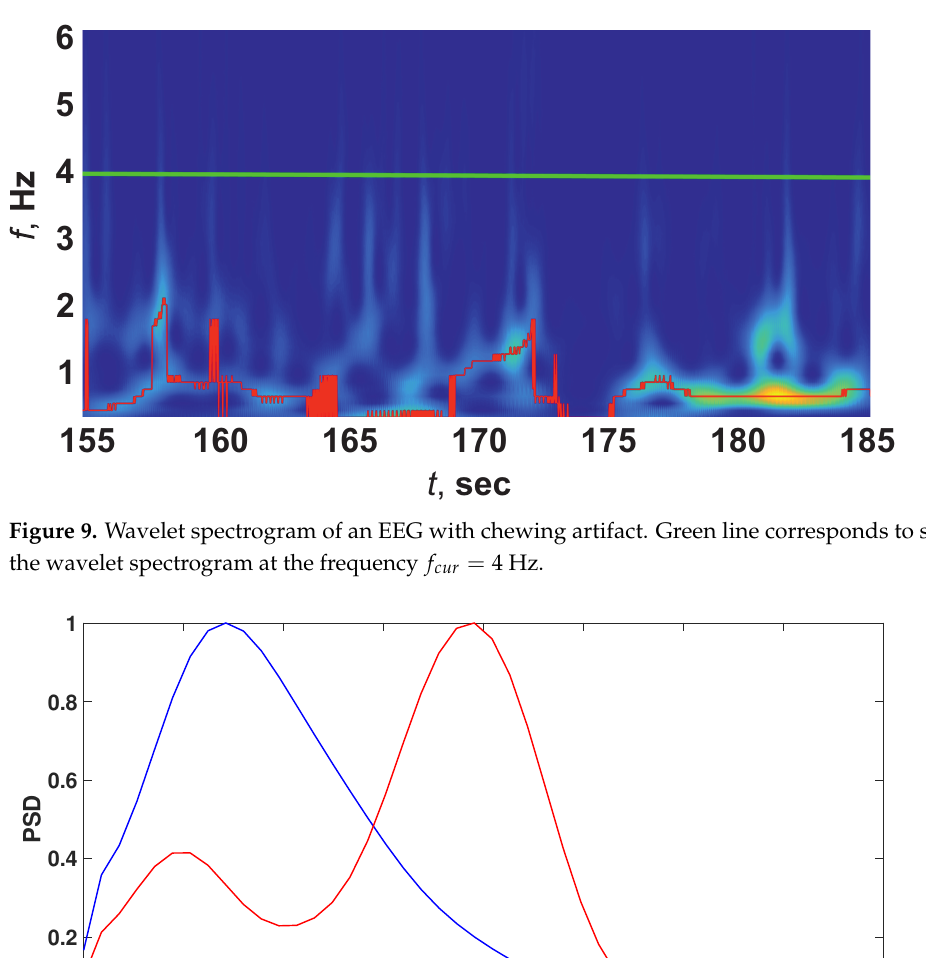
Figure 8. Wavelet spectrogram of an EEG with ES. Green line corresponds to slice of the wavelet spectrogram at the frequency f cur = 4 Hz.